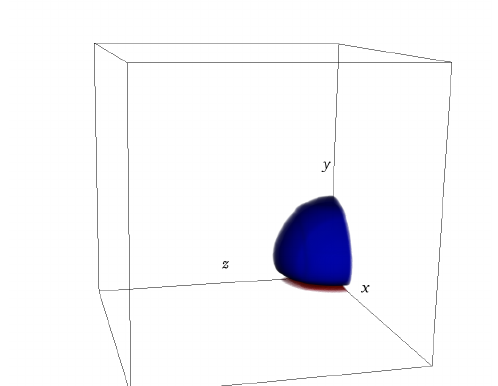
Figure 5 . Thanks to the symmetry of a dipole (and as well as quadrupole) CSQ, we only simulate the first octant with x, y, z > 0 and implement mirroring boundary conditions on the x - y , y - z and z - x planes, which provides a speed-up factor of